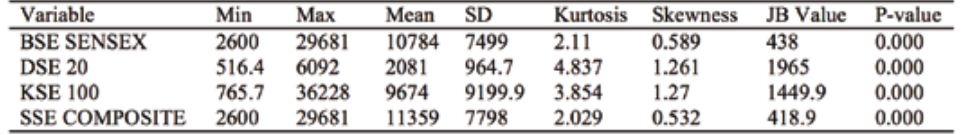
Table 1: Descriptive Statistics